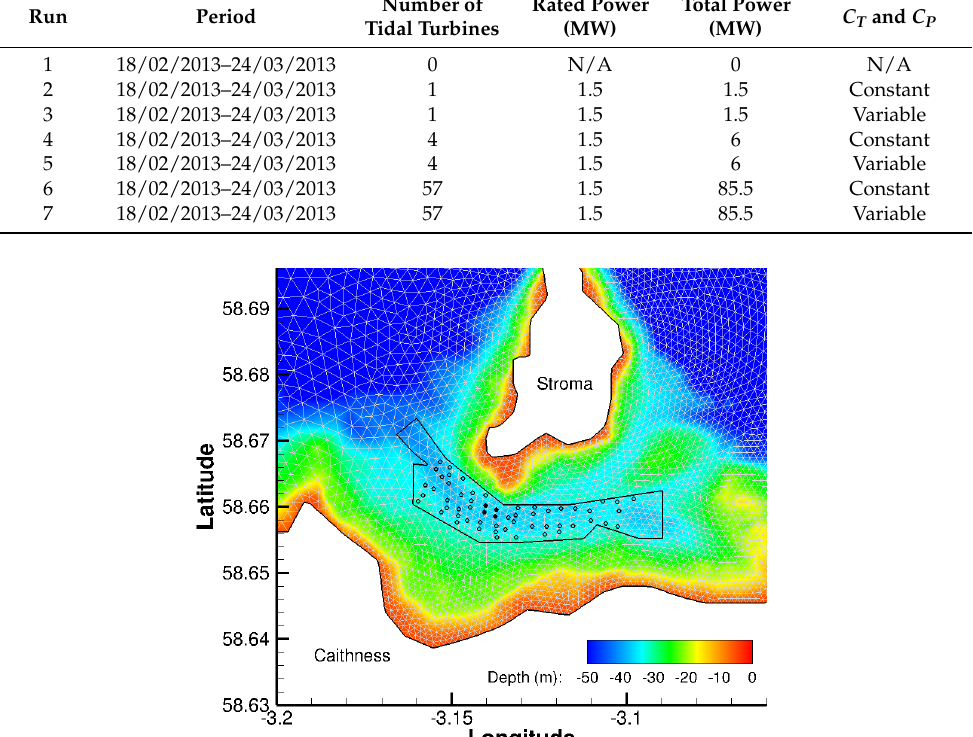
Figure 4. The locations of the tidal turbines simulated in the Inner Sound. The four turbines for Runs 4 and 5 are indicated by filled circles (●). The remaining 53 turbines (o) in the full array are randomly positioned within the lease area (―). Locations are overlain on the model grid and bathymetry.